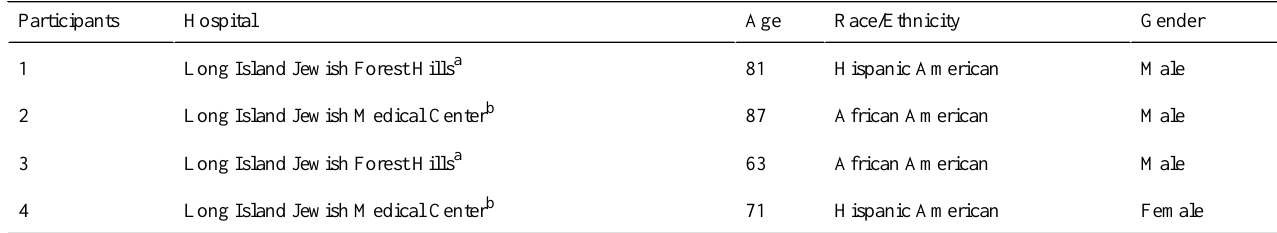
Table 1. Participant demographics (N=4). GenderRace/EthnicityAgeHospitalParticipants